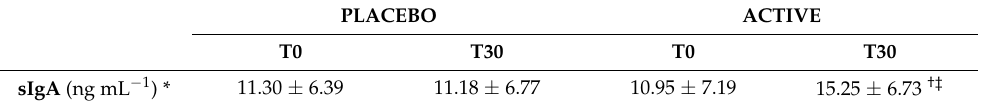
Table 5. sIgA concentration in the saliva (ng mL − 1 ) of subjects from the two groups studied before and after dietary